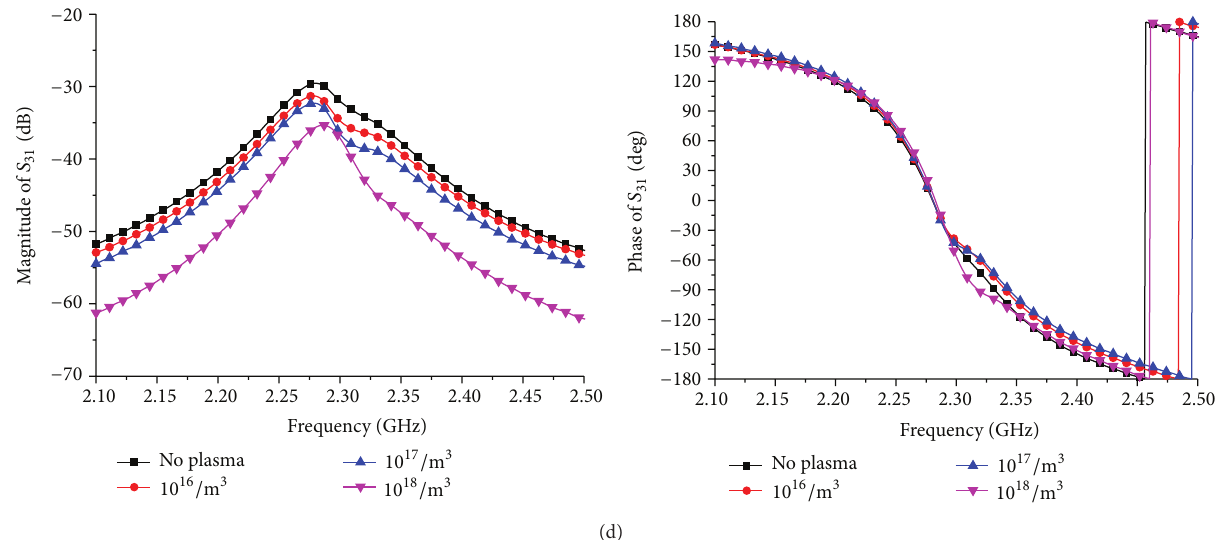
Figure 7: (a) Mutual coupling coefficient ( ] = 0.1 GHz) of diagonal elements. (b) Mutual coupling coefficient ( ] = 1 GHz) of diagonal elements. (c) Mutual coupling coefficient ( ] = 5 GHz) of diagonal elements. (d) Mutual coupling coefficient ( ] = 20 GHz) of diagonal